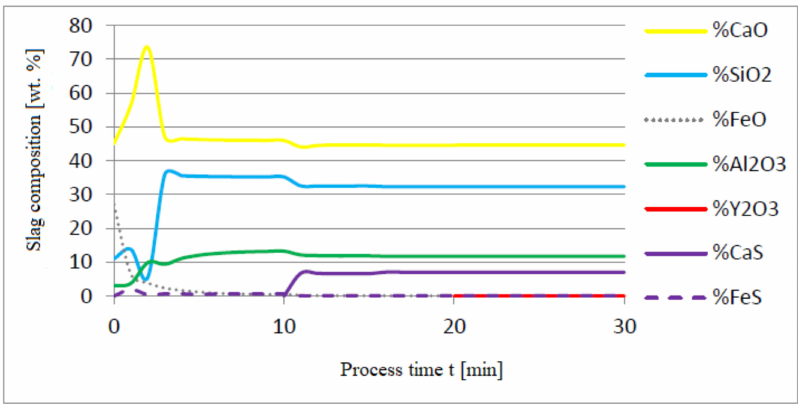
Figure 12. Change in chemical composition of slag (wt.%) depending on the process time t (min).